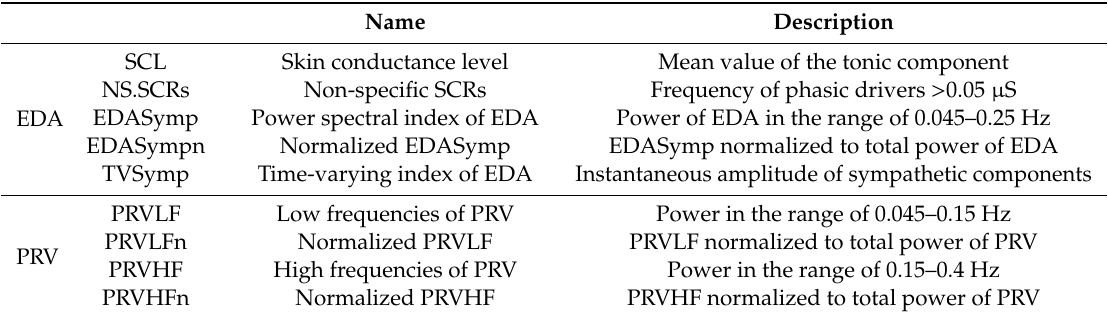
Table 2. Indices of autonomic response based on electrodermal activity (EDA) and pulse rate variability